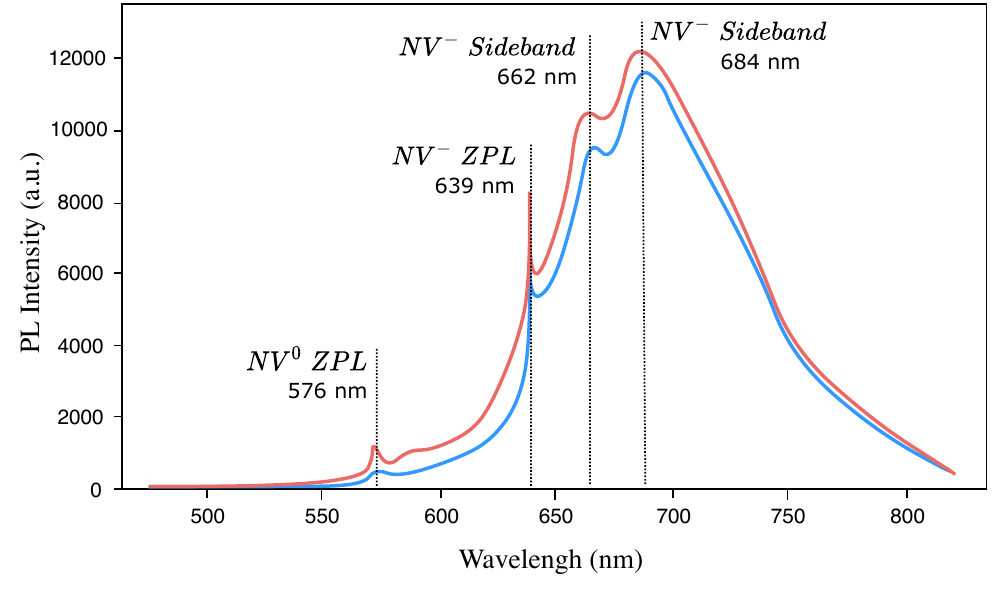
Figure A2. Photoluminescence spectra smoothed out for an NV spin